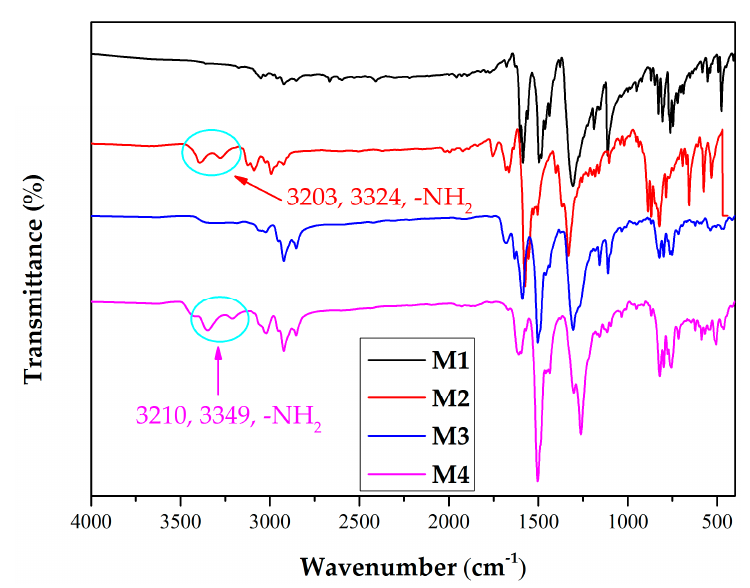
Figure A8. IR of Figure A8. IR of monomers. Figure A8. IR of monomers.